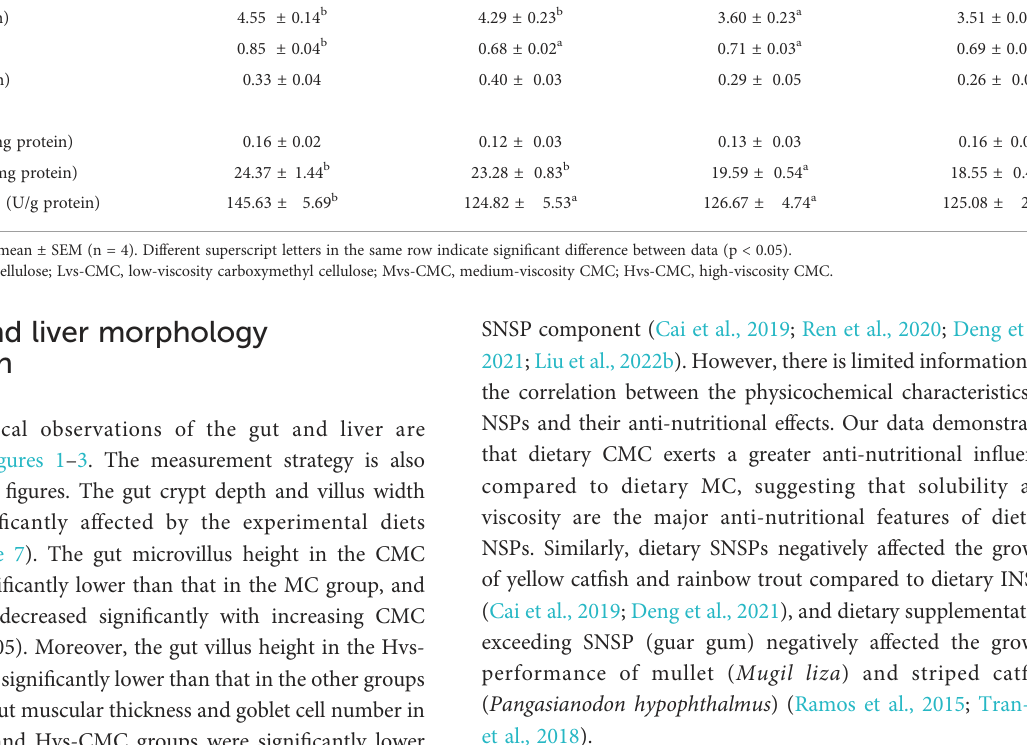
TABLE 5 Effects of increasing dietary viscosity on the intestinal digestive and absorptive enzyme activities of juvenile largemouth bass. Item